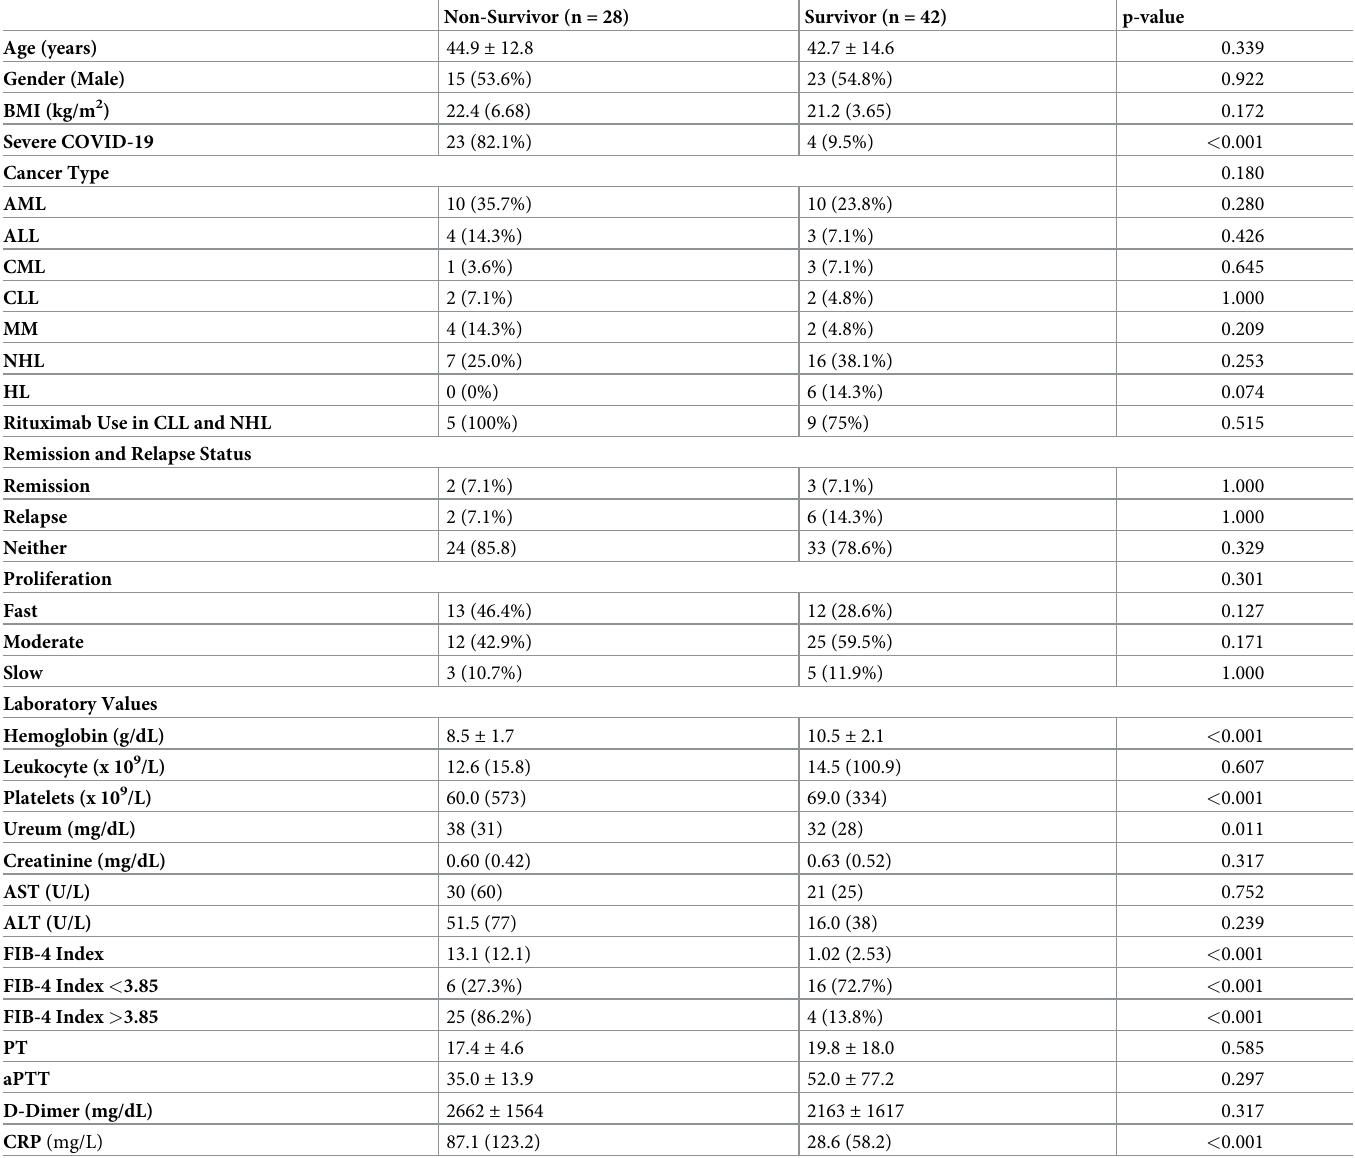
Table 1. Baseline